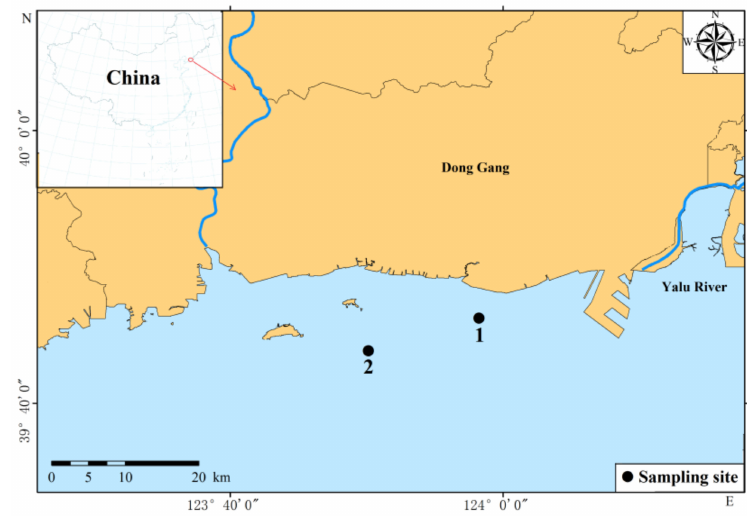
Figure 1. Sampling sites in Yalu River Estuary,